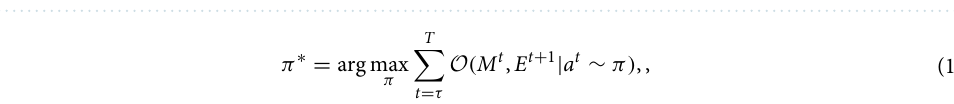
Figure 2. ( a ) Urban interregional mobility. ( b ) The modeling for pandemic transmission via mobility. ( c ) The modeling of interregional mobility